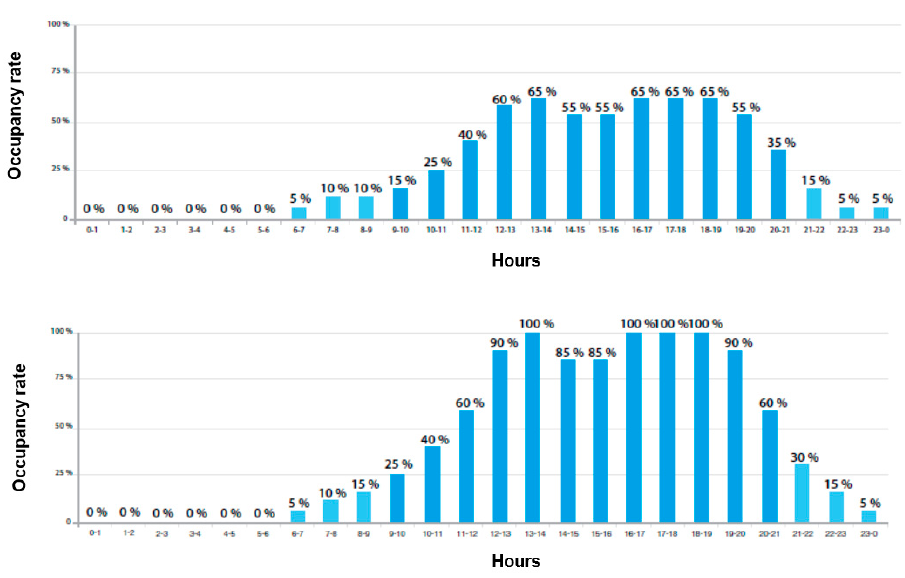
Figure 2. Hourly occupancy indices on working days (top) and holidays (bottom) [51].